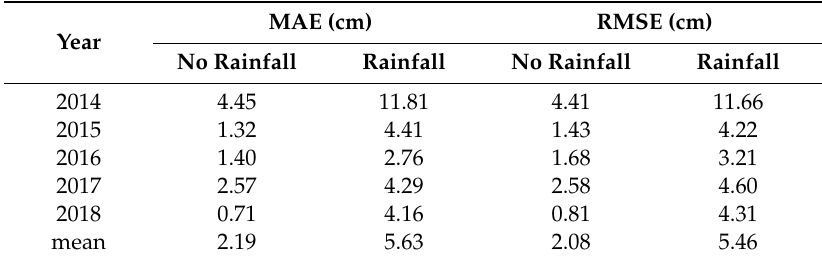
Table 4. Statistical results for estimated snow depths with respect to in-situ snow depth in situations with and without